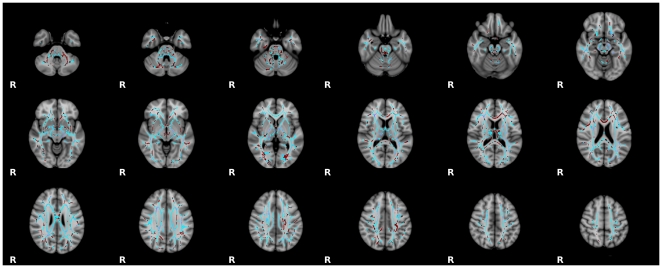
Model-Based Trajectory Analyses.Permutation-based non-parametric testing, using a general linear model containing linear and quadratic terms, revealed significant age-related changes in skeletonized white matter throughout the brain (p<0.05, corrected). We employed an F-test to determine optimal fit (linear vs. quadratic). Tracts for which the optimal fit was the inverted quadratic (‘U-shaped’) developmental trajectory are shown in blue, and those for which the optimal fit was the linear trajectory are shown in red.